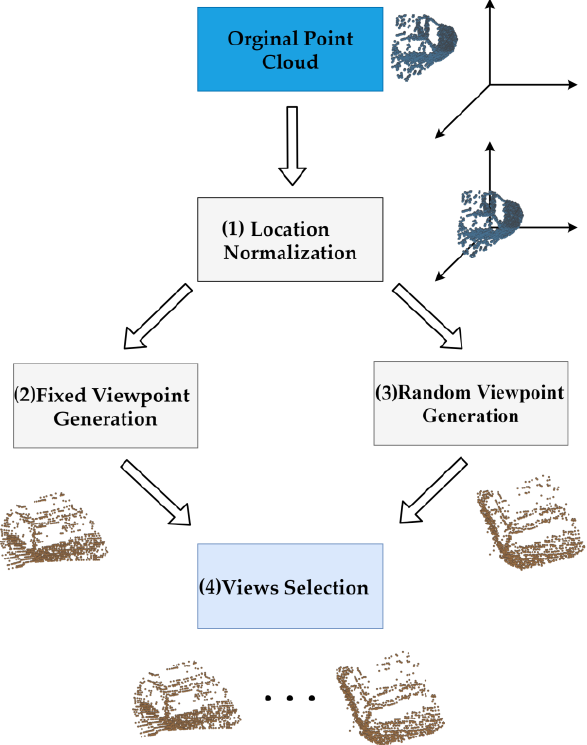
Figure 3. Multiview selection with a fixed random viewpoint.